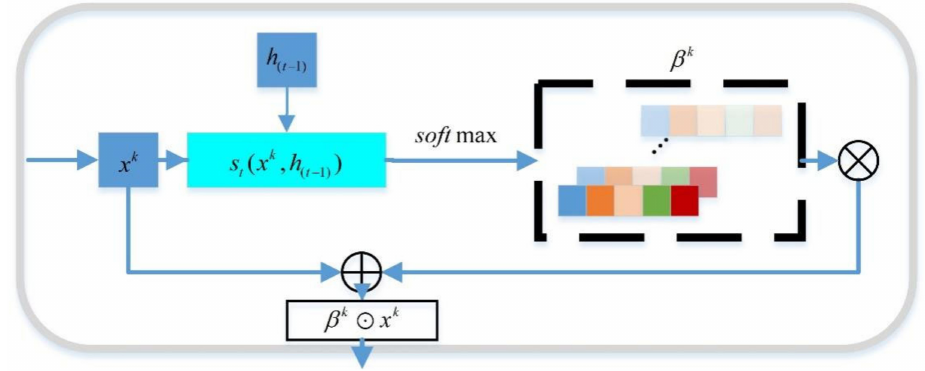
Figure 4. Spatial Attention Module.